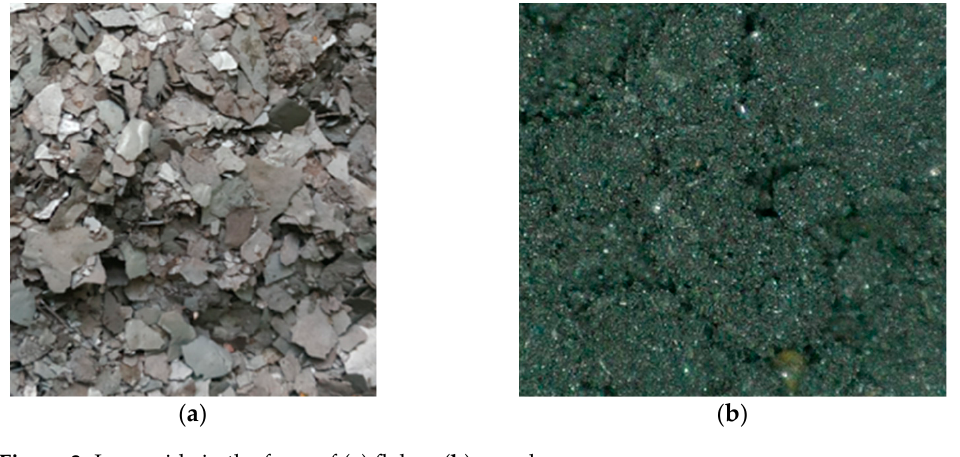
Figure 3. Iron oxide in the form of ( a ) flakes, ( b ) powder.